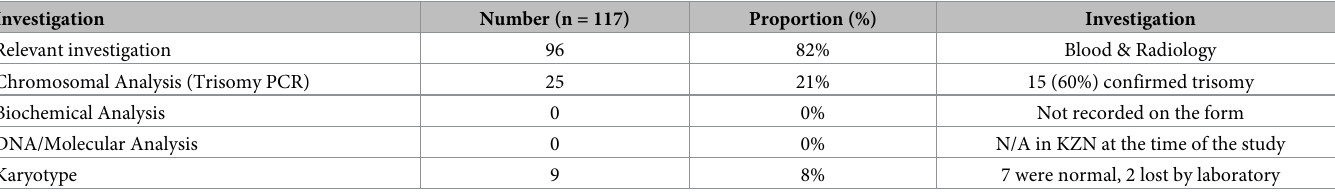
Table 3. Summary of investigations undertaken on neonates with congenital